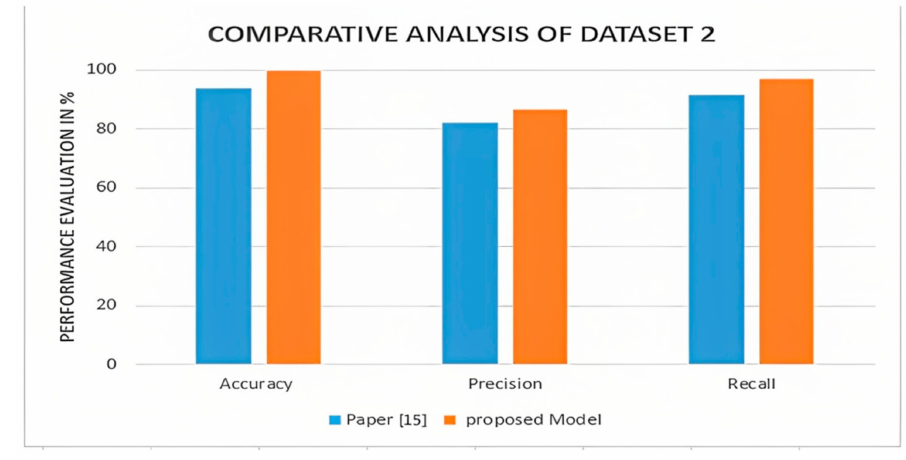
Figure 14. Comparative analysis graph of dataset 2.